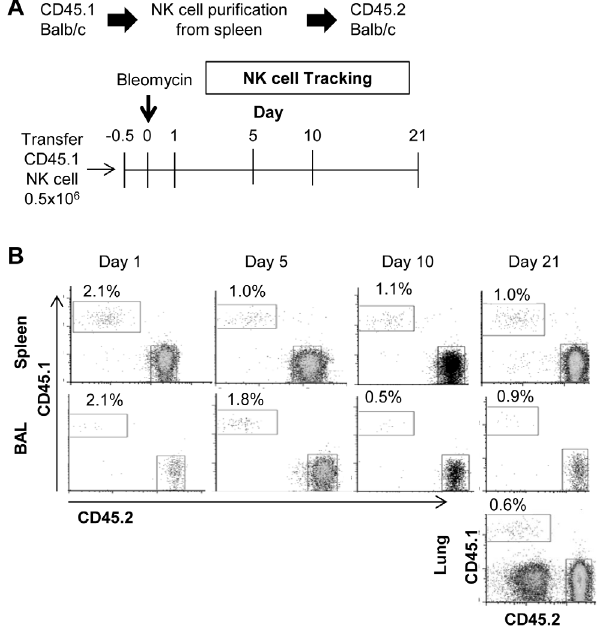
Figure 9. Distribution and abundance of adoptively trans- ferred CD45.1 + NK cells into CD45.2 + recipients during BIPF. ( A ) After NK cell purification by magnetic beads, 0.5 million CD45.1 + NK cells were injected i.v. into CD45.2 + recipients. Mice were injected intranasally with bleomycin (7.5 mg/kg) 12 h post-cell transfer ( B ) At the indicated time points, spleen, BAL fluid and lungs were harvested, and the donor (CD45.1 + ) and recipient (CD45.2 + ) NK cells (DX5 + CD3-) were quantified by flow